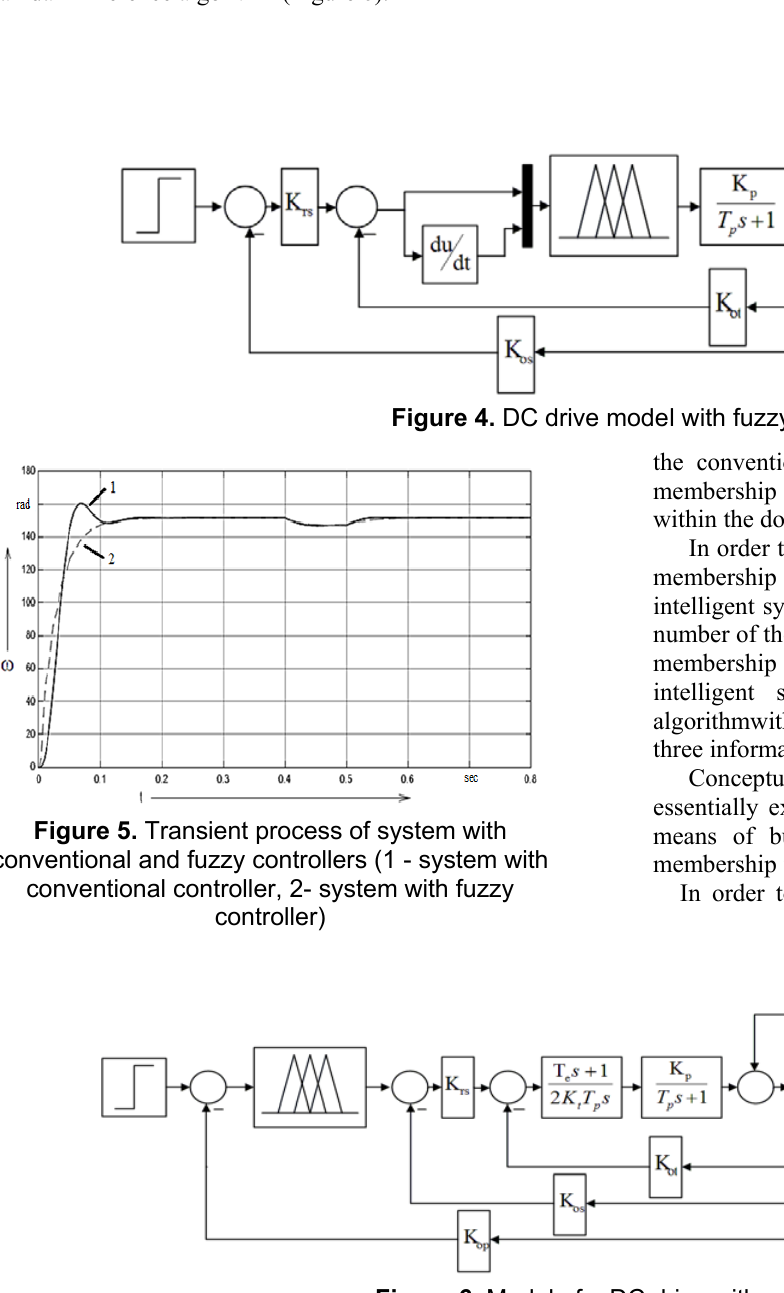
Figure 6. Model of a DC drive with a fuzzy